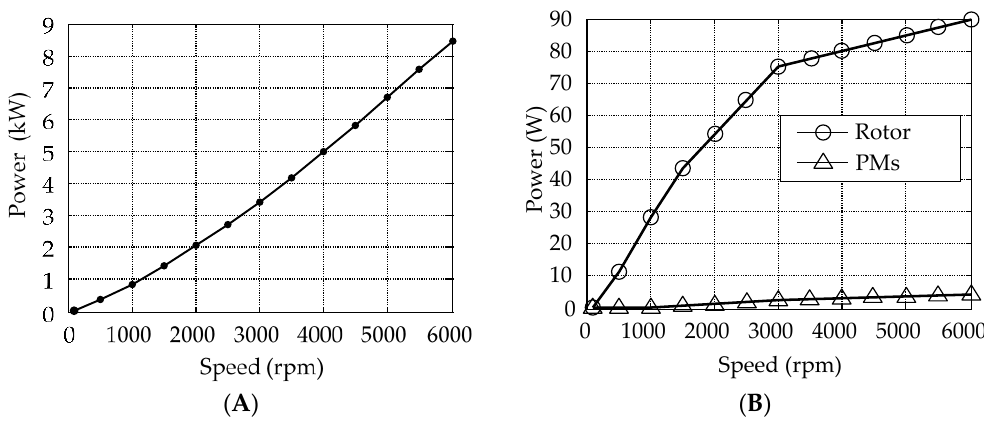
Figure 8. Calculated values of eddy thermal power in the: ( A ) stator; ( B ) rotor and PMs.